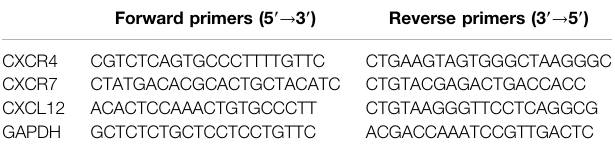
TABLE 1 | Primer sequences of human CXCR4, CXCR7, CXCL12, and GAPDH. Forward primers (5 9 → 3 9 )